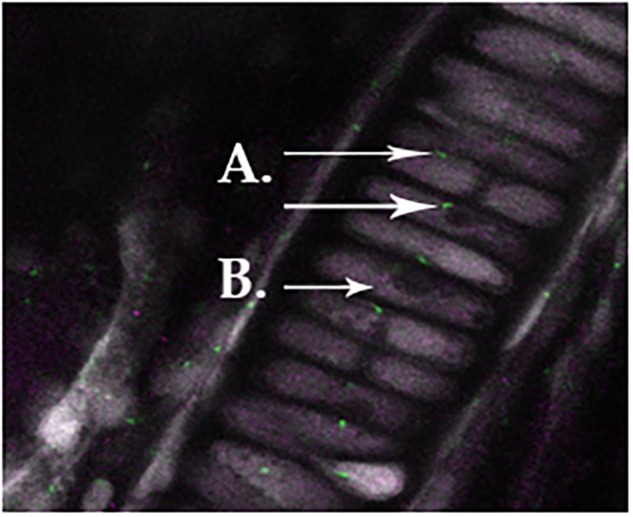
Normal primary cilia in zebrafish chondrocytes residing in the mandible, as indicated in green staining for acetylated α-tubulin (A). Ddr-2 is indicated by purple staining (B), demonstrating a lack of co-localization between primary cilia and Ddr-2.